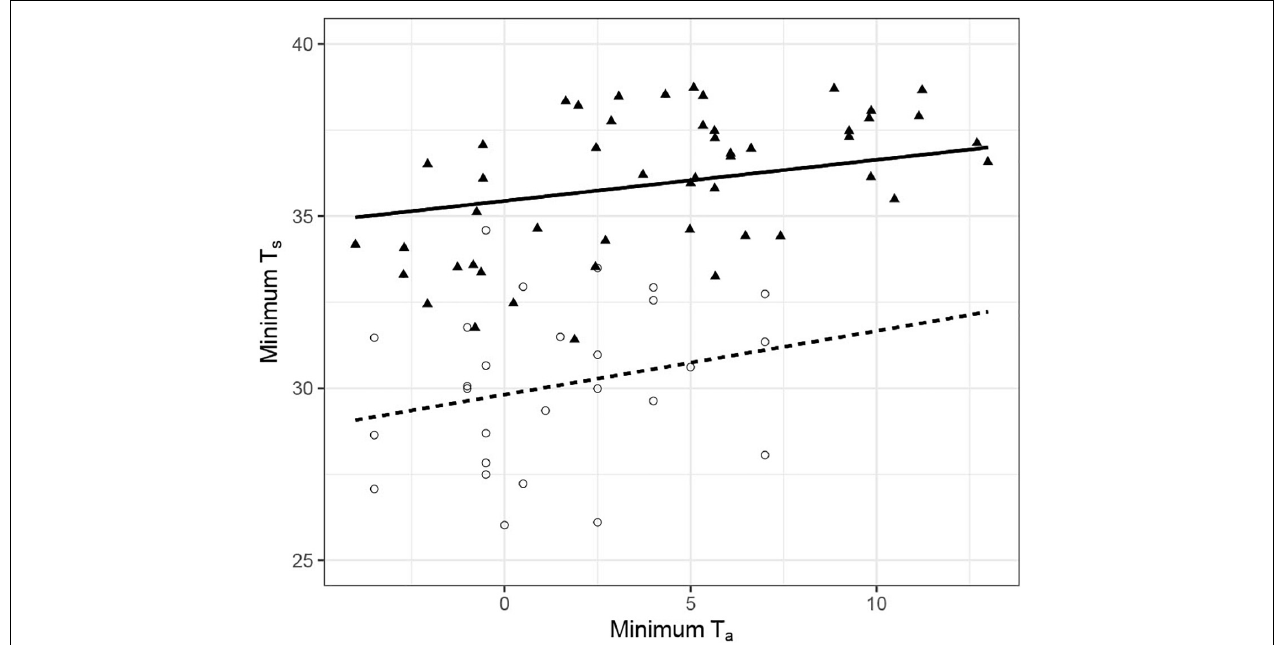
FIGURE 3 | The relationship between minimum skin temperature (T s ◦ C) and ambient temperature (T a ◦ C) in the eastern ( N = 4; open circles, dashed line) and western ( N = 7; filled triangles, solid line) yellow robin. Lines were fitted with a linear mixed effect model with minimum T s of robins from east and west population separately, in relation to minimum T a and bird identity as a random effect. Data for the western yellow robin was extracted from Douglas (2017). Like eastern robins (details of statistics in the text), the minimum T s of the wester robins were significantly affected by minimum T a ( T s = 35.44 + 0.11T a , df = 40, t = 2.86, P <